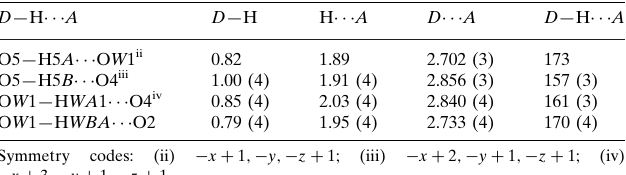
Hydrogen-bond geometry (A˚ , (cid:3)